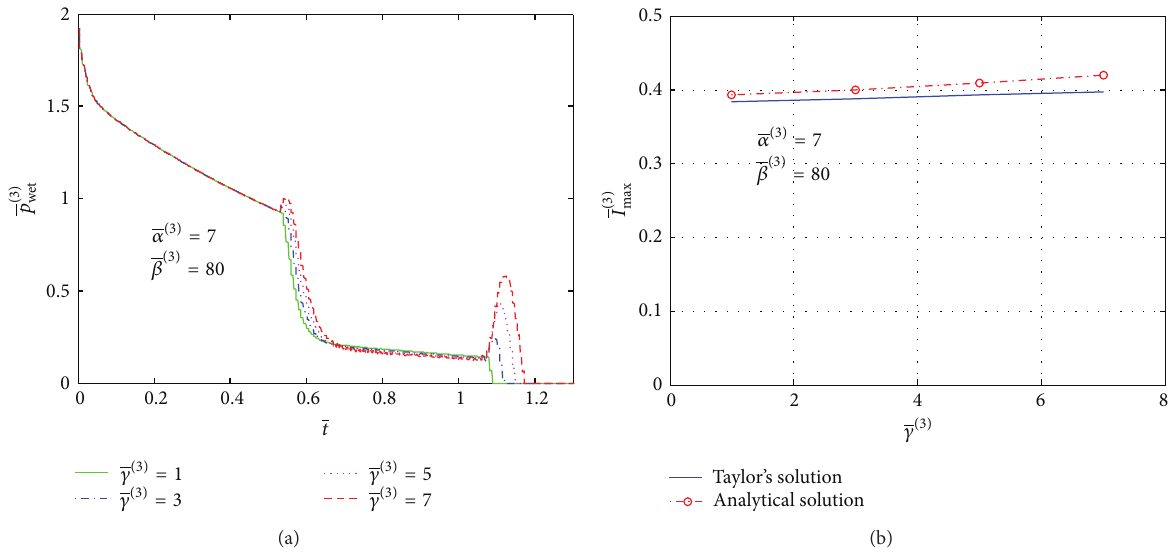
Figure 22: (a) The normalized time histories of the nondimensional pressure 𝑝 𝛾 (3) = 1 ∼ 10. (b) Sensitivity of the nondimensional impulse 𝐼 (3)